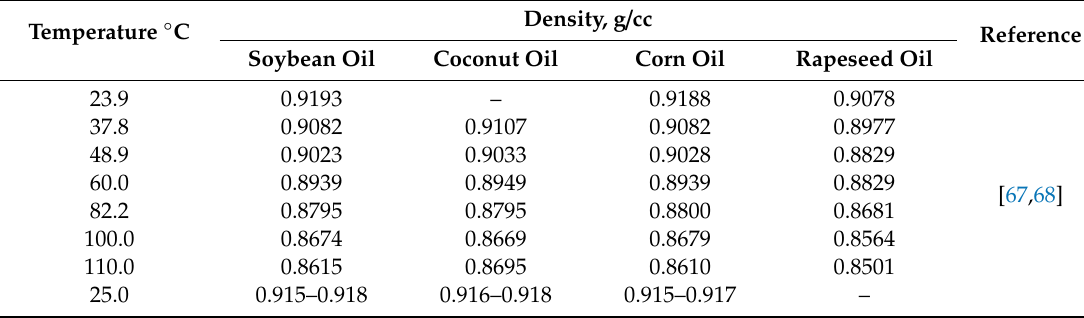
Table 8. Density measurements of di ff erent types of vegetable